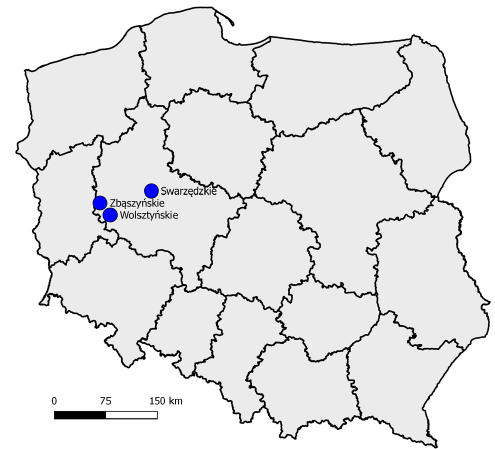
Fig. 3. Location of the lakes investigated on the background of the administrative division of Poland.